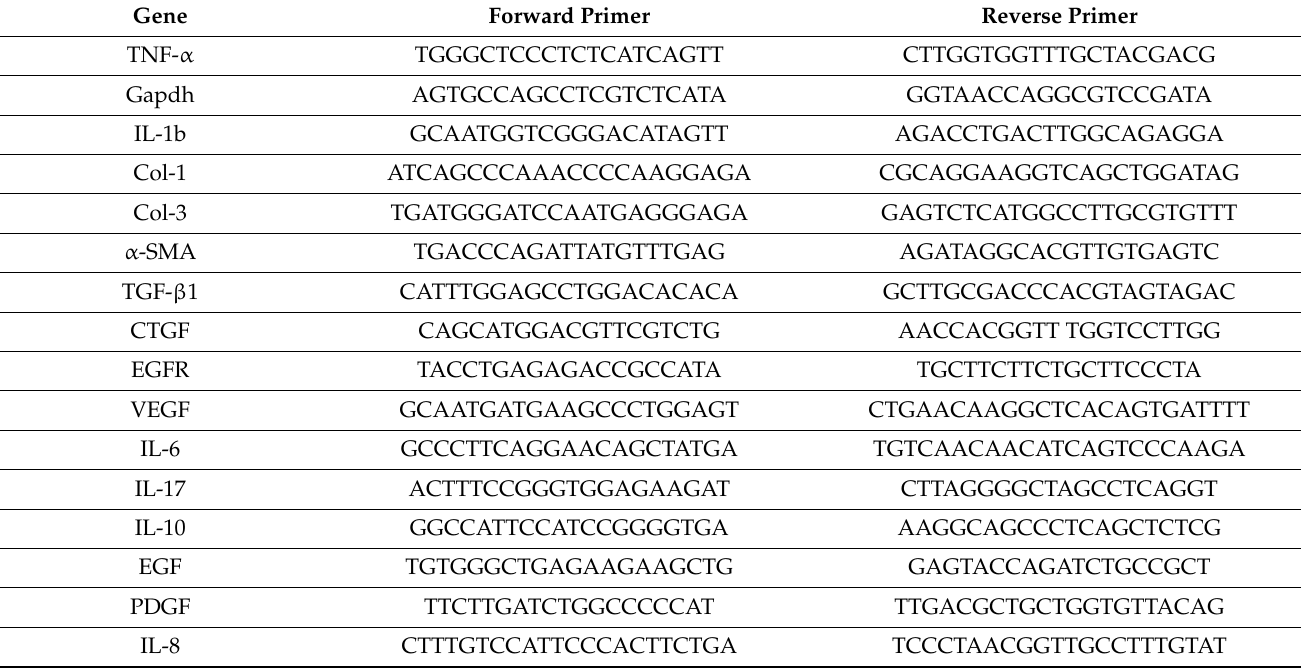
Table 1. Forward and Reverse sequences of primers used in